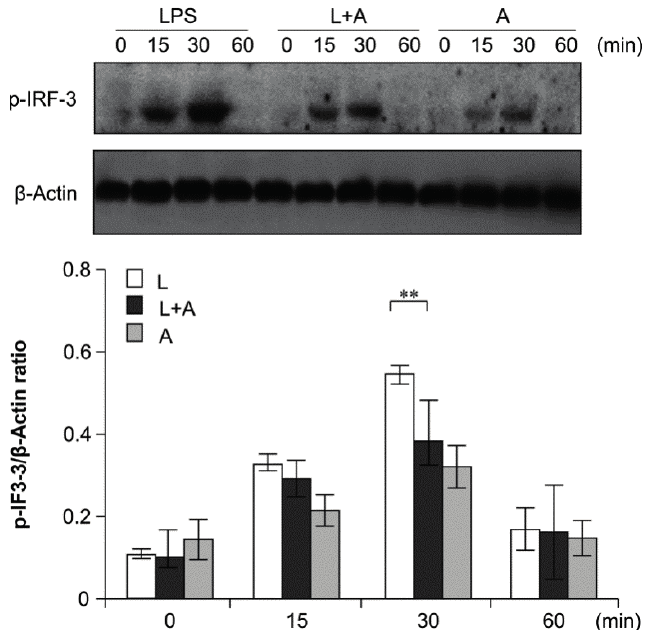
Figure 8. Western blot analysis for inhibition of IRF-3 activation by humanized anti-TLR4 antibody Fab. Cells were pretreated with humanized anti-TLR4 antibody for 2 h and further incubated in presence or absence of LPS (1 µg/mL). After immunoblotting, the phosphorylation level of IRF-3 was identified using phosphor-specific antibody. β -Actin was used to ensure equal loading. L: LPS, A: humanized anti-TLR4 antibody. Data are shown as mean ± SD ( n = 3, * p < 0.05, ** p < 0.01 versus LPS